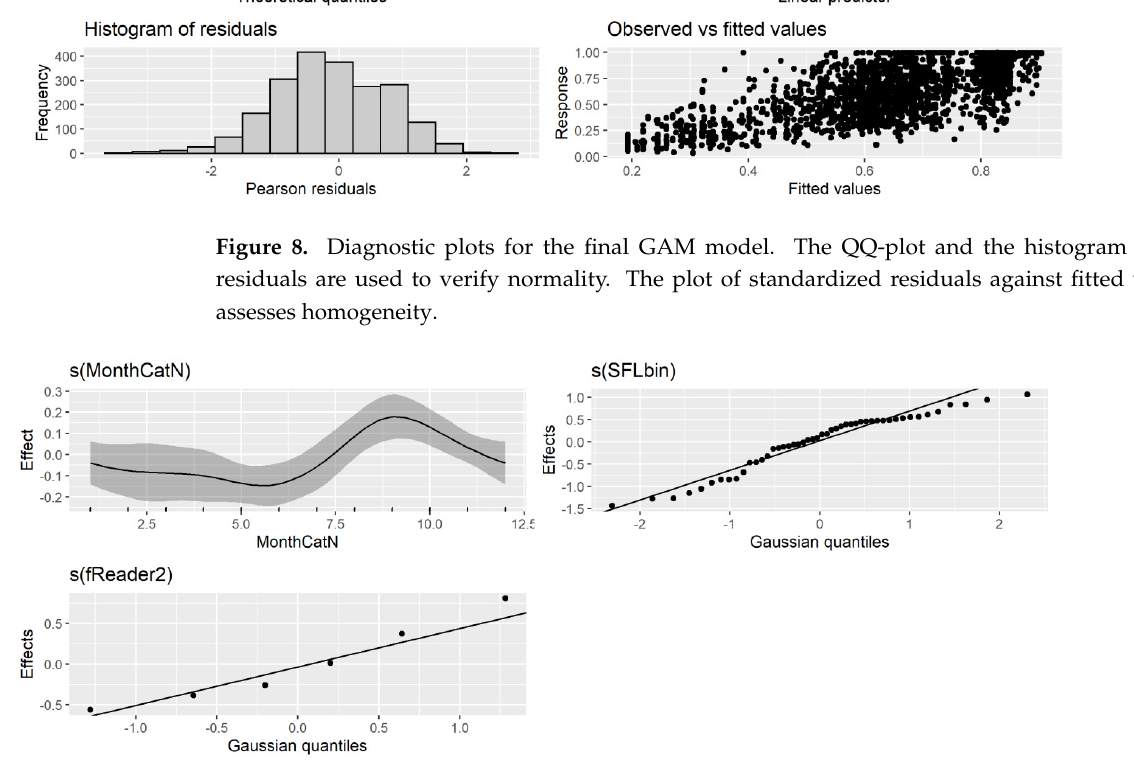
Figure 9. Estimated smoothing effects obtained by the GAM model.